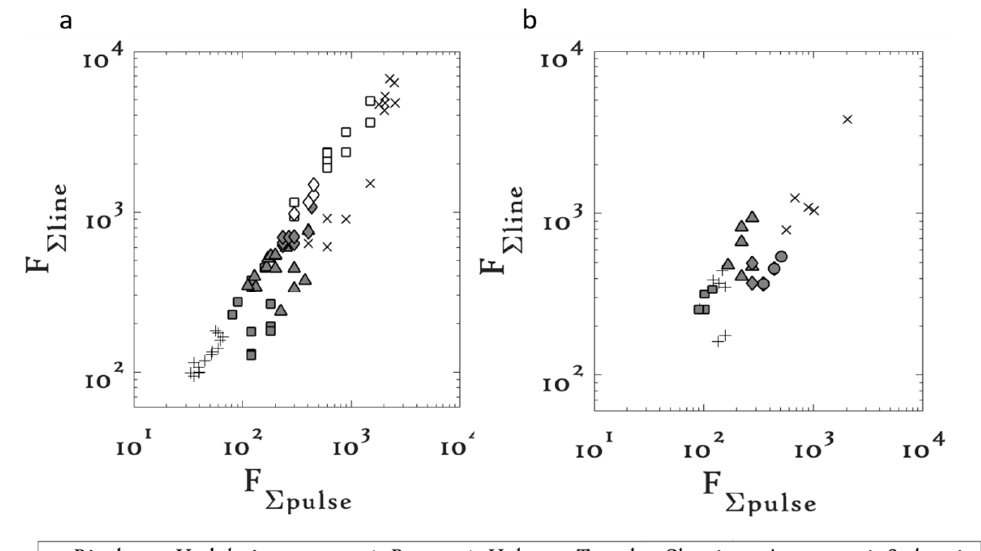
Figure 4. (cid:1832) (cid:2954)(cid:3039)(cid:3036)(cid:3041)(cid:3032) vs. (cid:1832) (cid:2954)(cid:3043)(cid:3048)(cid:3039)(cid:3046)(cid:3032) plots on Ti at ( a ) 1 kHz and ( b ) 10 kHz [23]. Figure 4. F Σ line vs. F Σ pulse plots on Ti at ( a ) 1 kHz and ( b ) 10 kHz